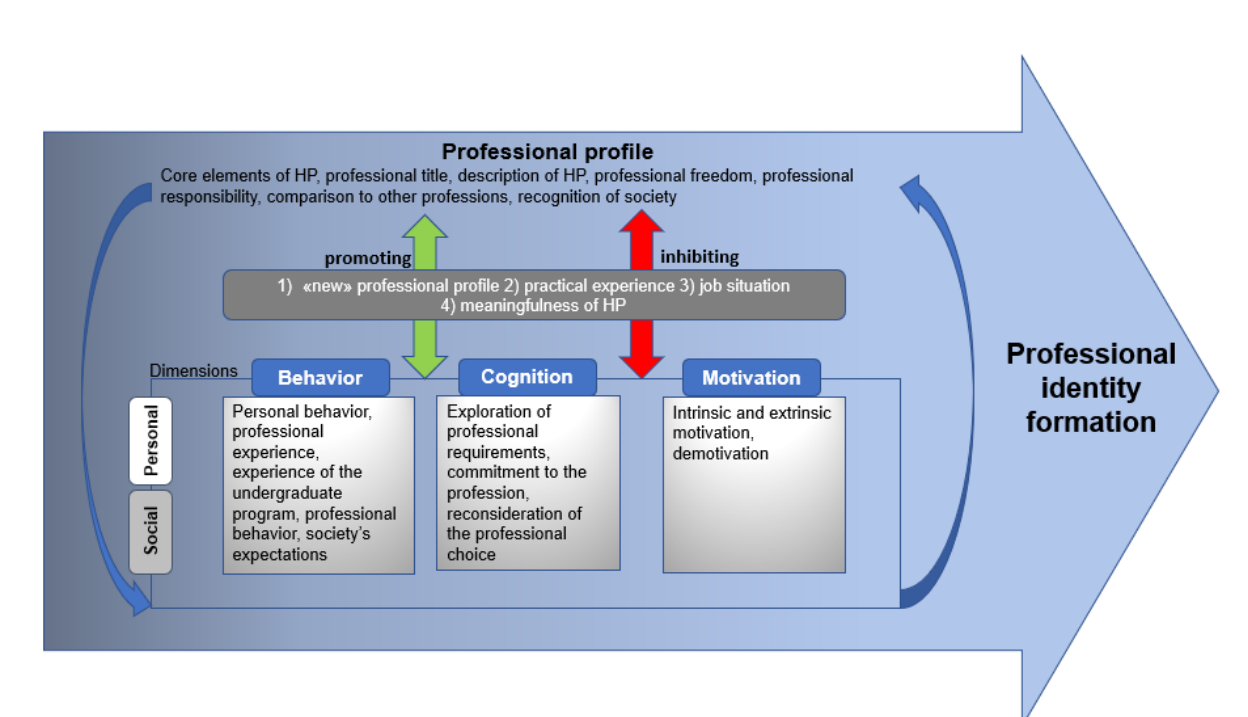
Figure 2. Model of professional identity formation of undergraduate students in health promotion and prevention in Switzerland derived out of the focus group results.